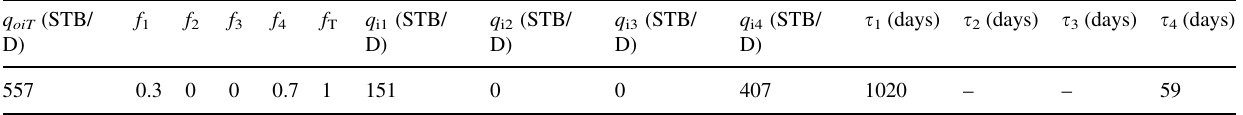
Fig. 3 Example application of the parallel flow model. a Normalized rate/time plot for the data and model history match and c normalized rate/cumulative plot for the data and model history match. b Cross- Table 1 Summary of model fitting parameters obtained for the parallel flow model applied to a well in the dataset q oiT (STB/